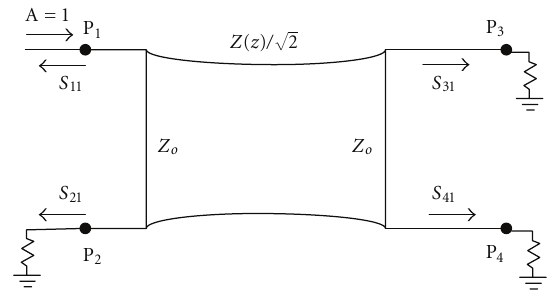
Figure 1: Geometry structure of a new nonuniform branch line coupler design with exponential impedance taper at the series arm.